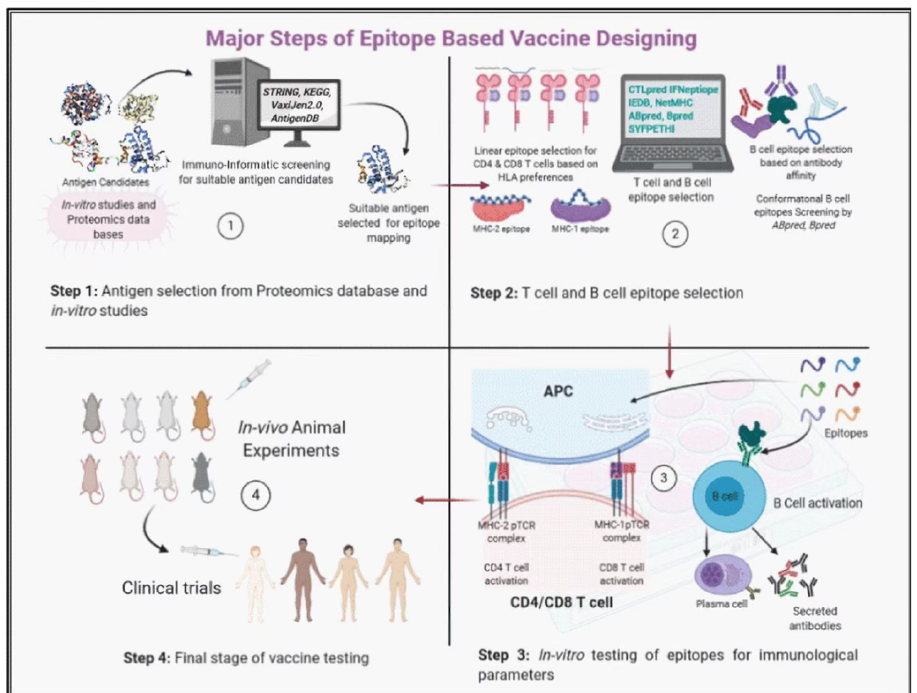
Figure 3. The illustration describes successive steps in epitope-based vaccine designing (this figure was adopted from Aryandra Arya and Sunil K Arora [103]. (1) In vitro antigenic epitope selection, identification, and analysis by using multiple immunoinformatic software from proteomic databases; (2) immunogenic B and T cell epitope selection by epitope insertion and sequence analysis; (3) synthesis of the designed neutralizing epitopes in the form of particulate, and evaluation of humoral and cellular immune responses by in vitro testing; (4) In vivo animal immunization to analyze the antibody responses to functionally characterize the anticipated neutralizing Abs- and cell-mediated immune responses.